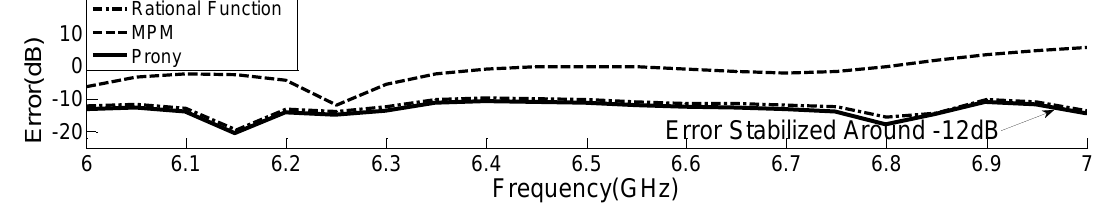
Figure 4. Jet Plane RCS prediction errors at 21 deg.